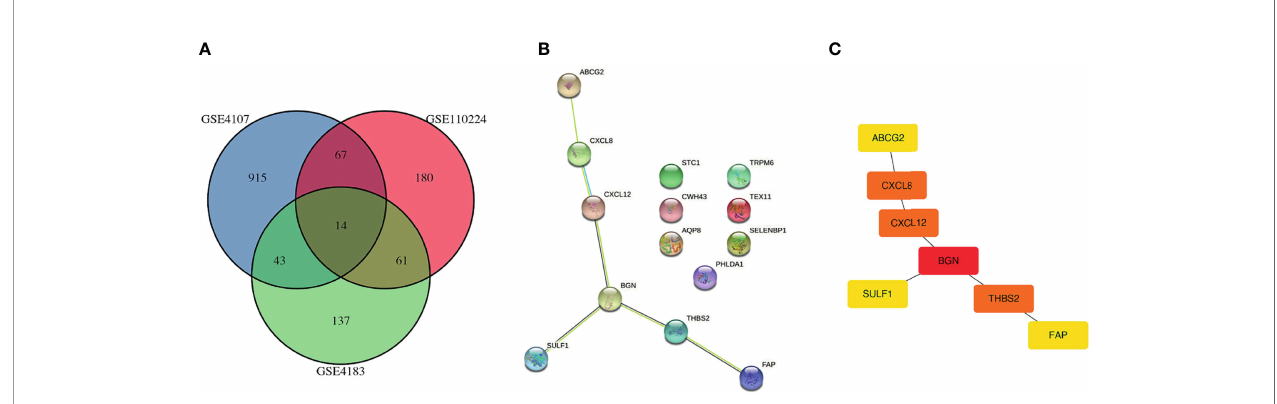
FIGURE 1 | Identi fi cation of overlapping DEGs. (A) Venn plots of overlapping DEGs in GSE4107 dataset, GSE110224 dataset and GSE4183 dataset. (B) PPI of 14 DEGs using the STRING database (https://string-db.org). (C) PPI network of DEGs were constructed and visualized by Cytoscape software. PPI, protein-protein interaction; DEG, differentially expressed gene.